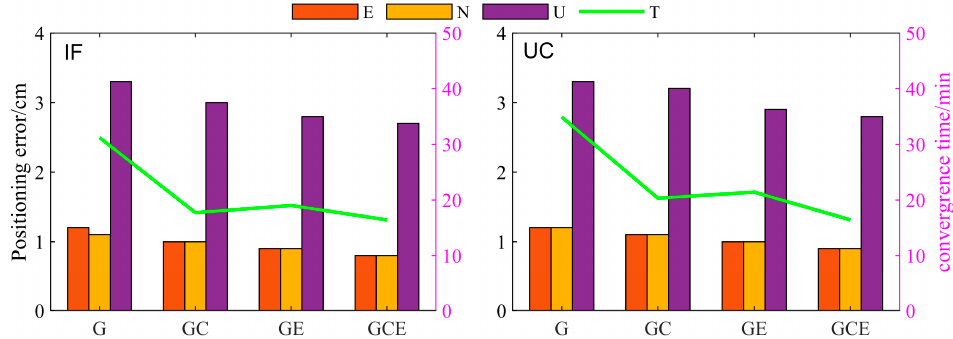
Figure 13. The RMS results of positioning error and convergence time of the IF model ( left ) and the UDUC model ( right ) G, GE, GC, and GCE kinematic PPP-AR on DOY 300–306, 2021, for 22 stations.